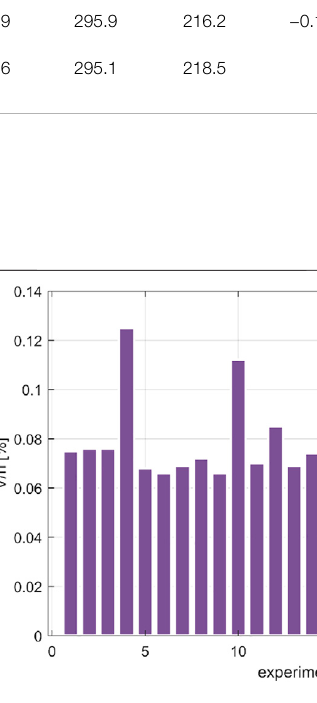
FIGURE 9 | Air leakage evaluation in terms of percentage of volume per hour in the 27 days life test on lettuce in the PCU (during day 21 an aeration was performed, thus the leakage is not reported).